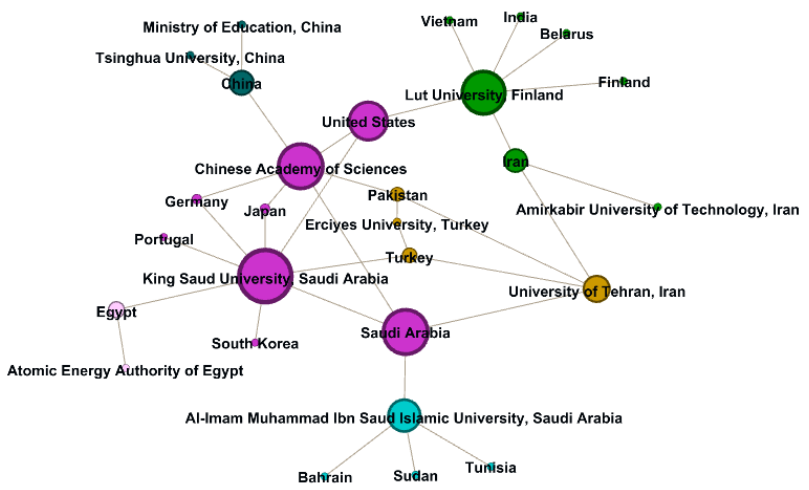
Figure 3. Countries’ co-authorship network of the top 10 institutions.